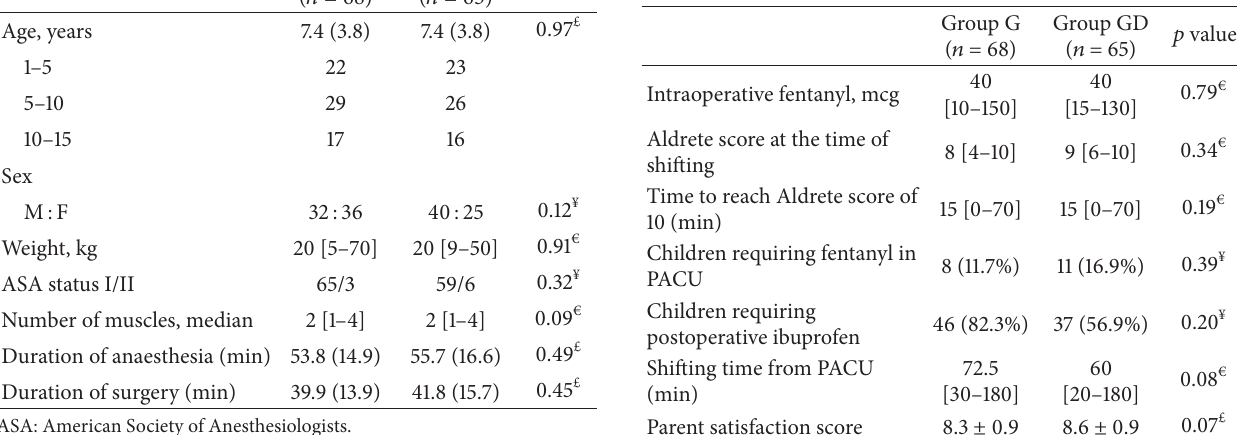
Table 1: Patient’s demographic profile. Table 2: Analgesic requirement, Aldrete score, and parent satisfac- tionscore.Valuesareinmean ± SD,number(percentage),ormedian